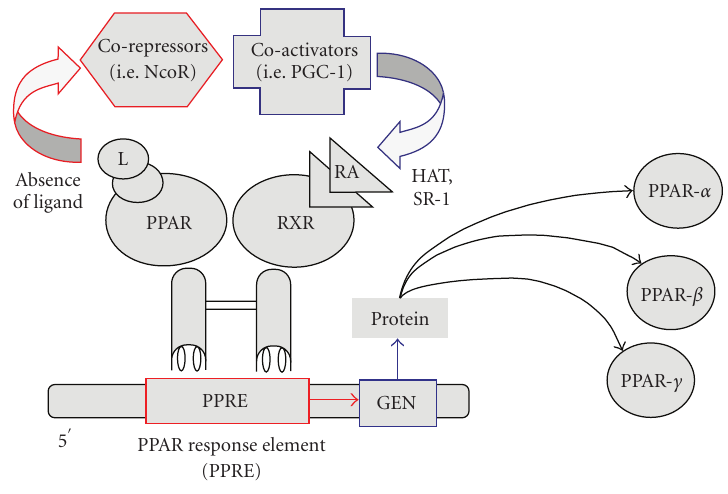
Figure 1: Schematic of PPAR activation events. Like other nuclear hormone receptors, PPAR acts as a ligand-activated transcription factor. PPAR- α , when activated after binding with specific ligand, interacts with RXR and regulates the expression of target genes. These genes are also involved in the catabolism of fatty acids. Conversely, PPAR- γ is activated by di ff erent ligands (e.g., prostaglandins, leukotrienes, and antidiabetic thiazolidinediones) and regulates the expression of genes involved in the storage of the fatty acids. PPAR- β is only weakly acti- vated by fatty acids, prostaglandins, and leukotrienes and has no known physiologically relevant ligand. Abbreviations: nuclear corepressor protein: (NcoR); PPAR gamma coactivator 1:(PGC-1); histone acyltransferase: (HAT); steroid receptor coactivator-1: (SR-1); 9-cis retinoic acid: